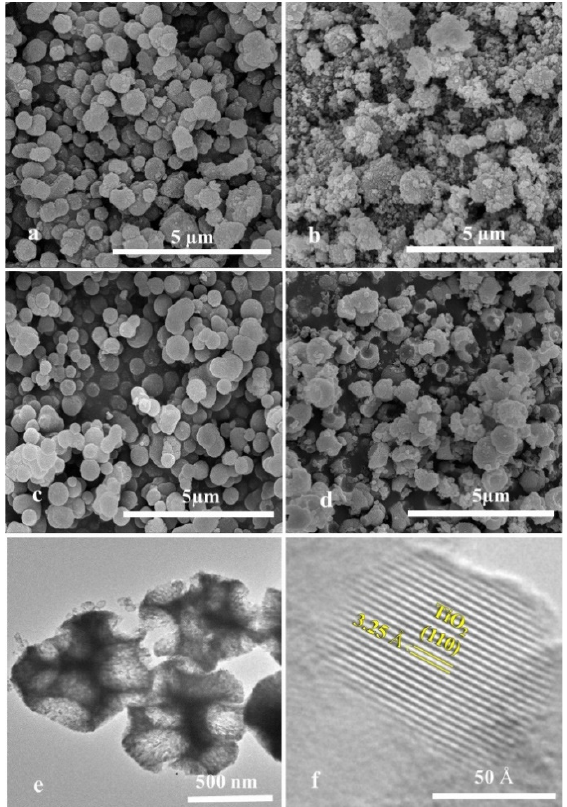
Figure 2. SEM micrographs of TiO 2 _HS_Ac and TiO 2 _HS_EtOH titania before ( a , c ) and after calci- nation ( b , d ), respectively, and TEM micrographs of TiO 2 _HS_EtOH ( e , f ). Following the coating process, the TiO 2 layer evenly surrounded the CS templates, thus retaining their morphology (Figure 2a,c). However, after calcination, the structure of